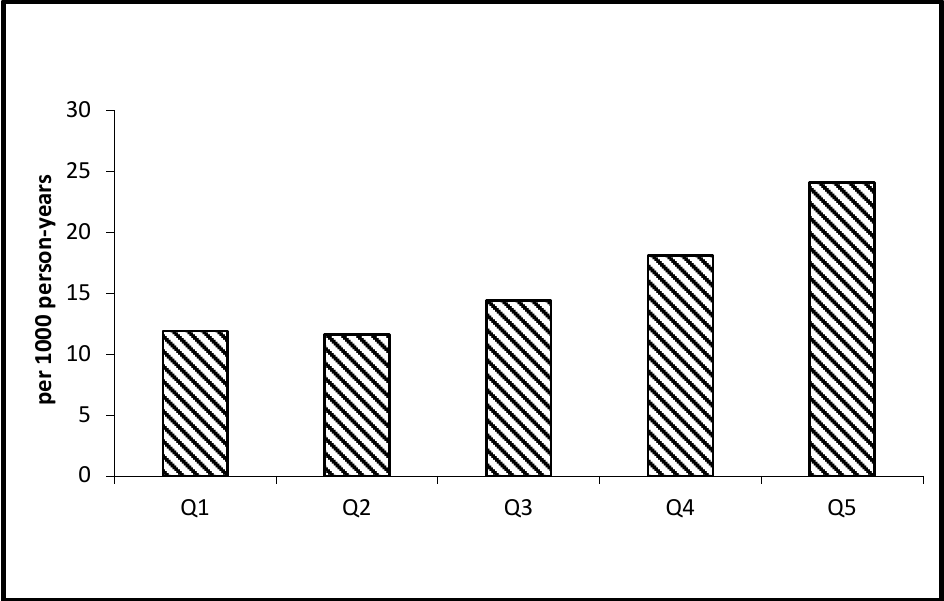
Figure 1. Age-adjusted incidence of CHD by glucose quintiles; trend test p < 0.001.